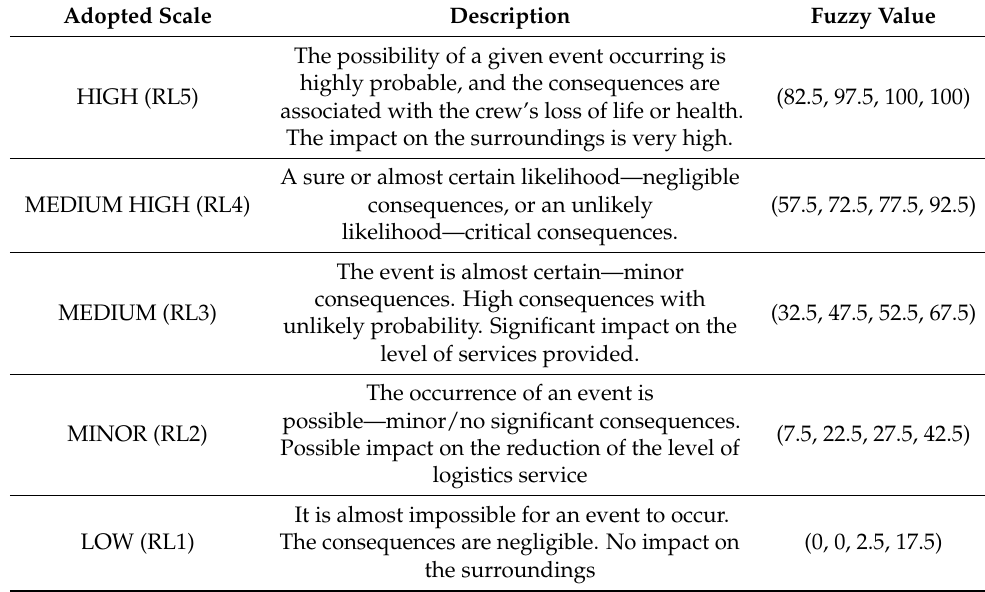
Table 7. Matrix of the calculating level of risk .